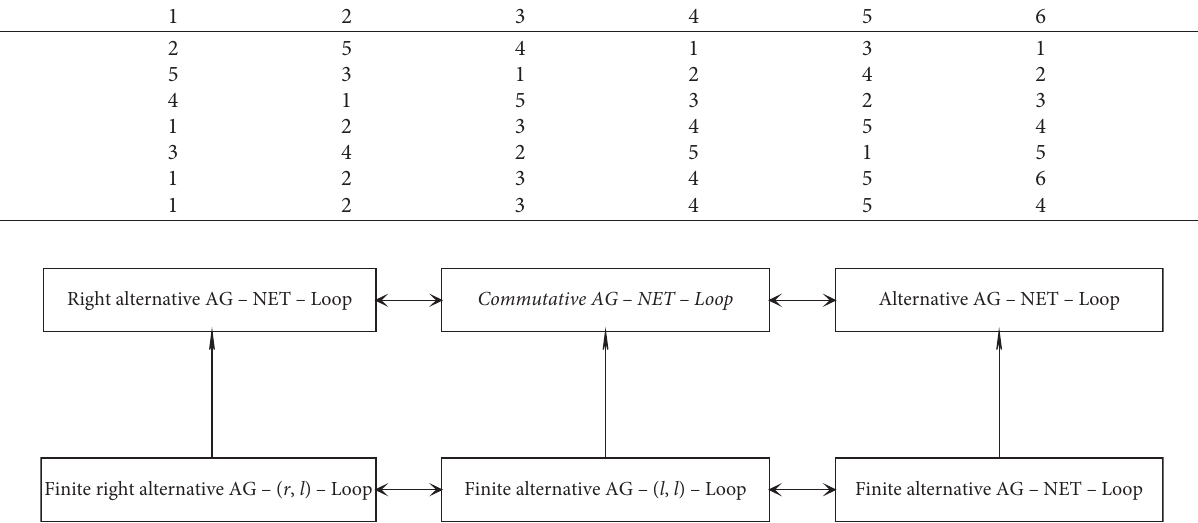
Figure 4: The relationships among alternative AG-NET-Loop and other alternative quasi AG-NET-Loops.